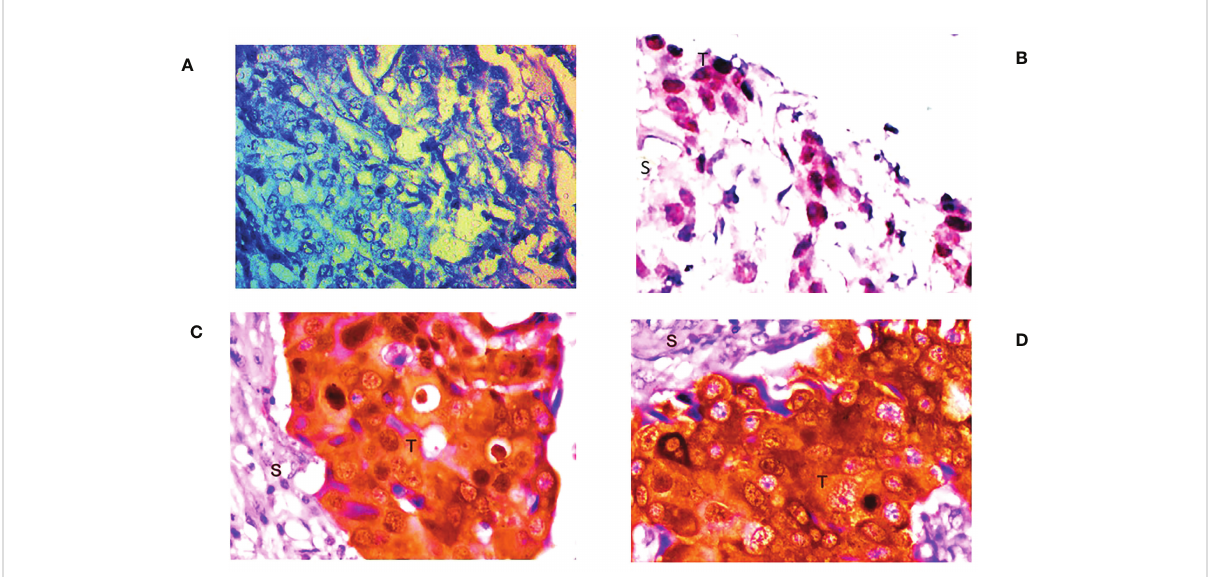
FIGURE 3 Representative picture of Immunohistochemical staining of human breast cancer tissue samples by anti-FOXO3a antibody (magni fi cation: 400x) showing (A) no expression, (B) low (+) expression (C) moderate (++) expression, and (D) high (+++) expression of FOXO3a. S: stromal tissue, T: tumor tissue.